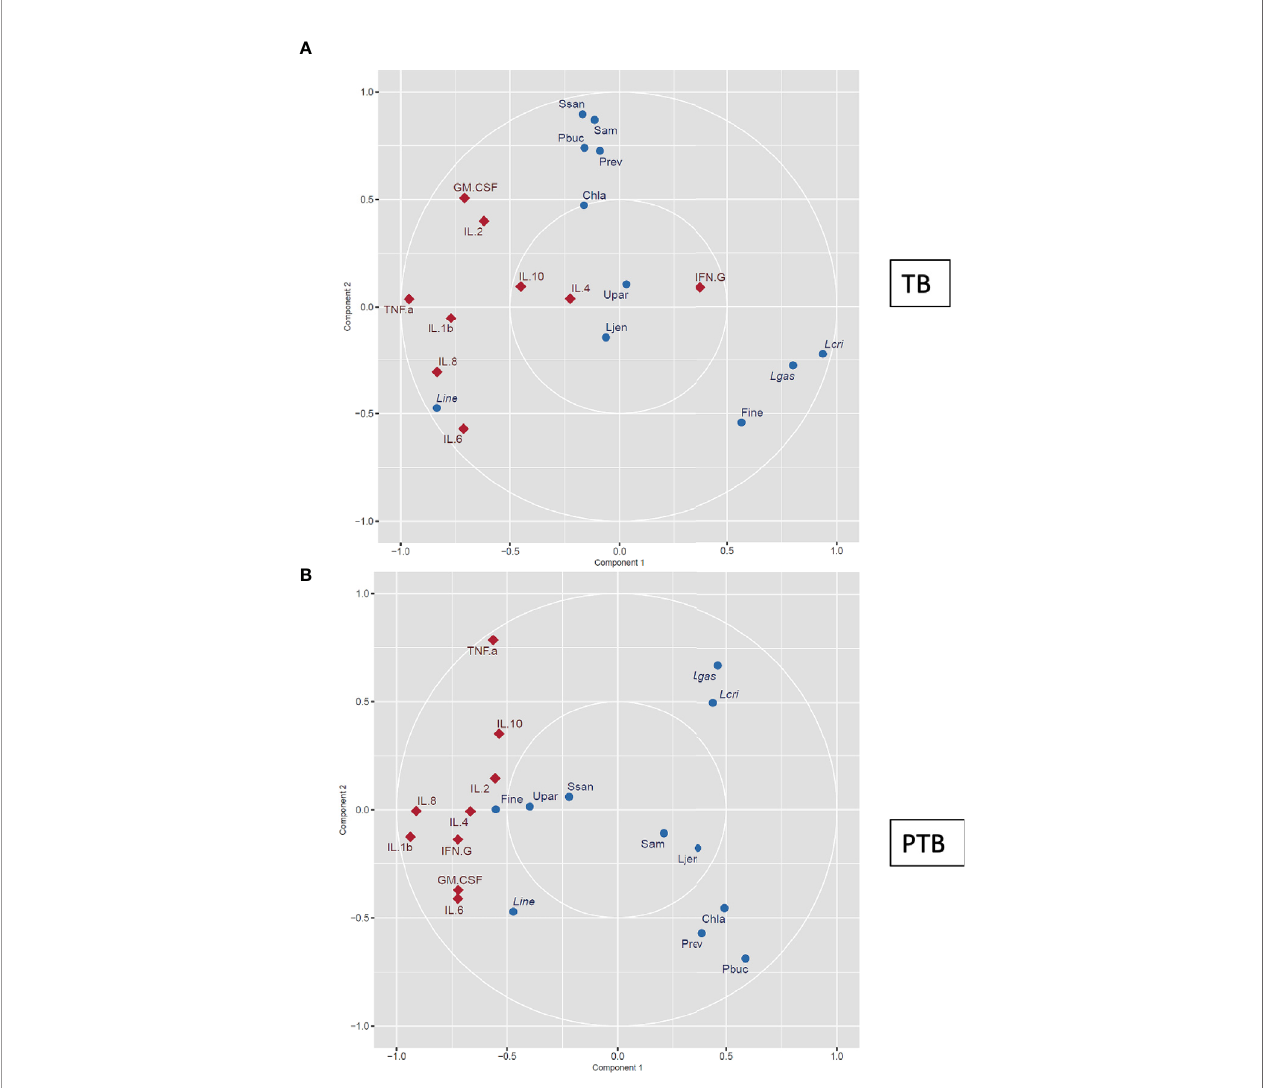
FIGURE 8 | Canonical correlation analysis of vaginal microbial signature and cytokine levels. The vaginal microbial taxonomic pro fi les and cytokine levels in samples collected from women who experienced (A) TB and (B) PTB at the fi rst trimester (8 – 14 weeks) were log-transformed and co-integrated using canonical correlation analysis. Cytokines are represented as red diamonds, and bacteria are represented as blue circles. Positively correlated variables are grouped together, while negatively correlated variables are positioned on opposite sides of the plot origin. Thus cytokines or microbial taxa that are clustered tightly are highly correlated, and factors that are distant from each other are not correlated. Pbuc, Prevotella buccalis ; Fine, Finegoldia ; Chla, Chlamydia trachomatis ; Lcri, Lactobacillus crispatus ; Line, Lactobacillus iners ; Lgas, Lactobacillus gasseri; Ljen, Lactobacillus jensenii; Prev, Prevotella 6; Ssan , Sneathia sanguinegens ; Upar, Ureaplasma parvum; Sam , Sneathia amnii